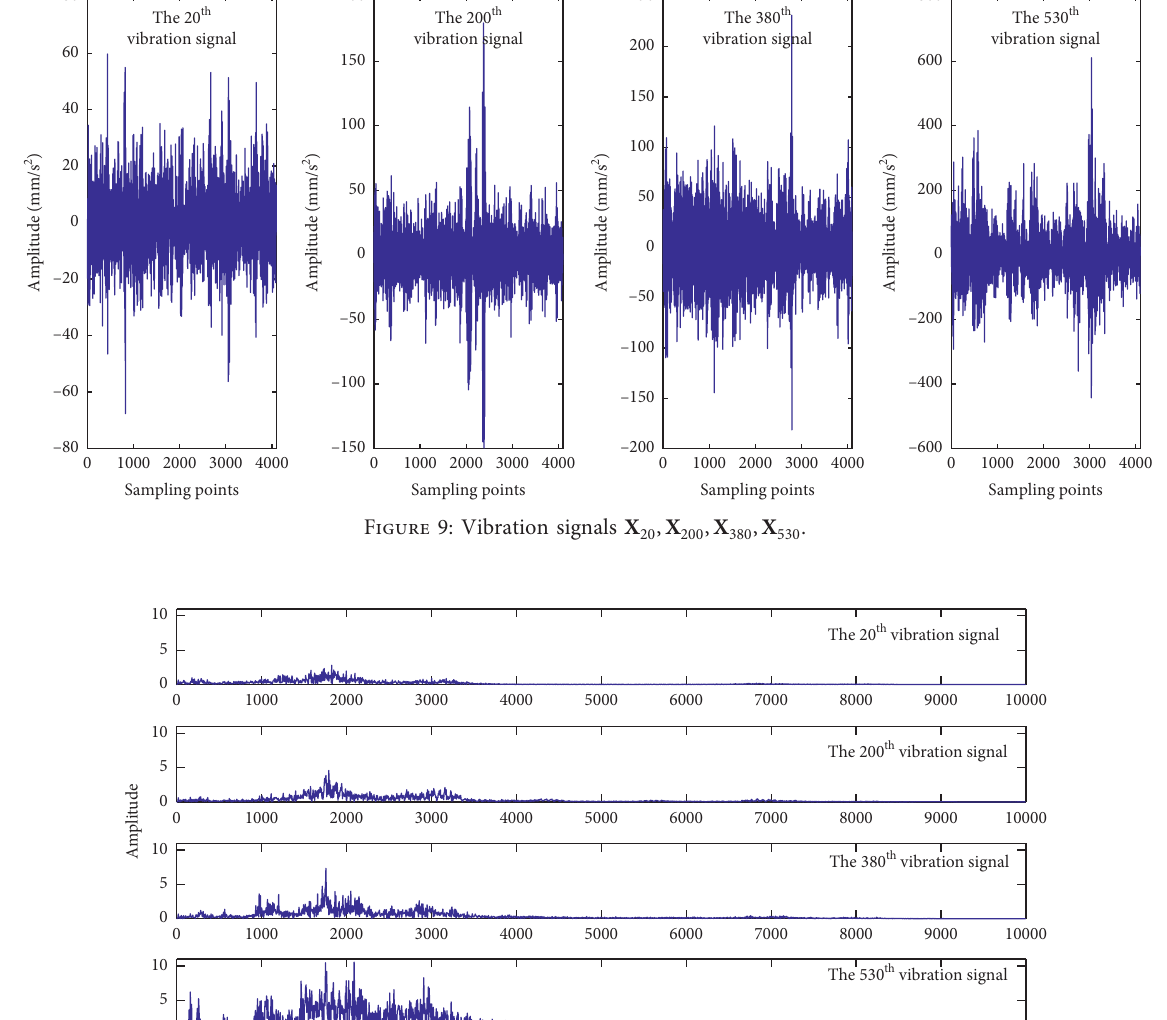
, X , X , X 20 200 380 530